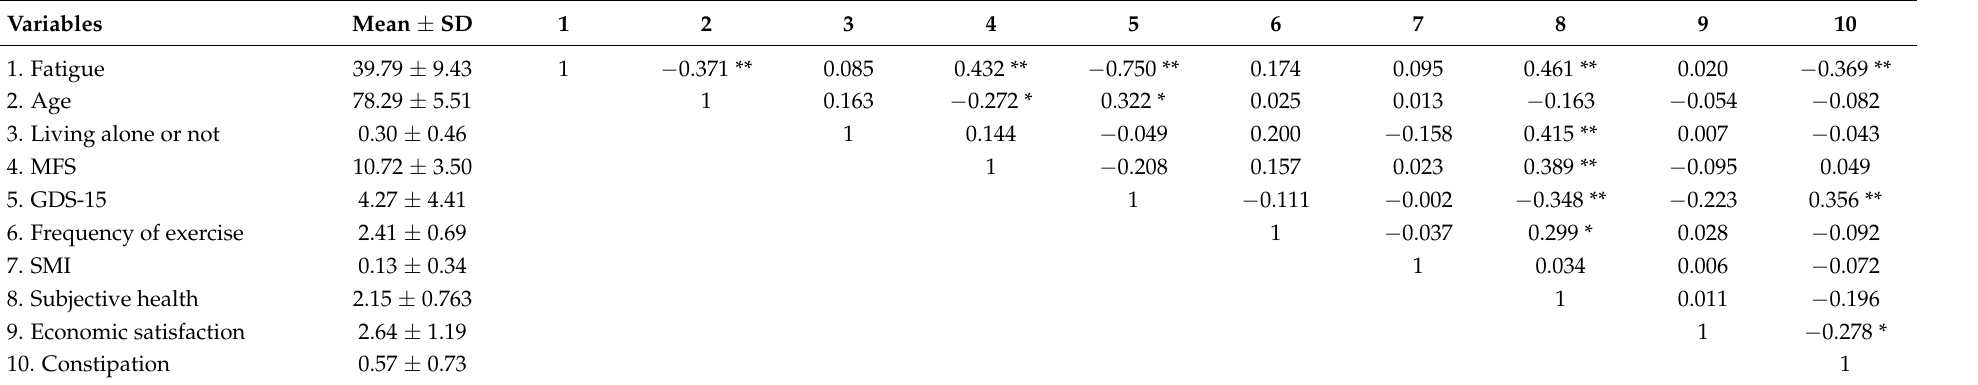
Table 2. Correlation analysis between fatigue and explanatory variables.